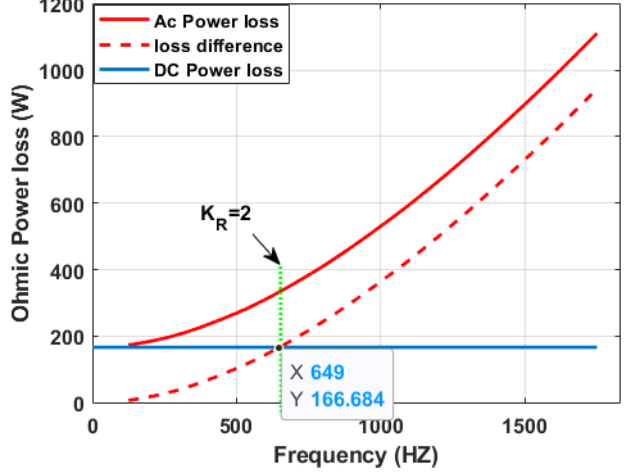
Figure 5. DC and AC losses versus frequency at ambient temperature (20 °C).